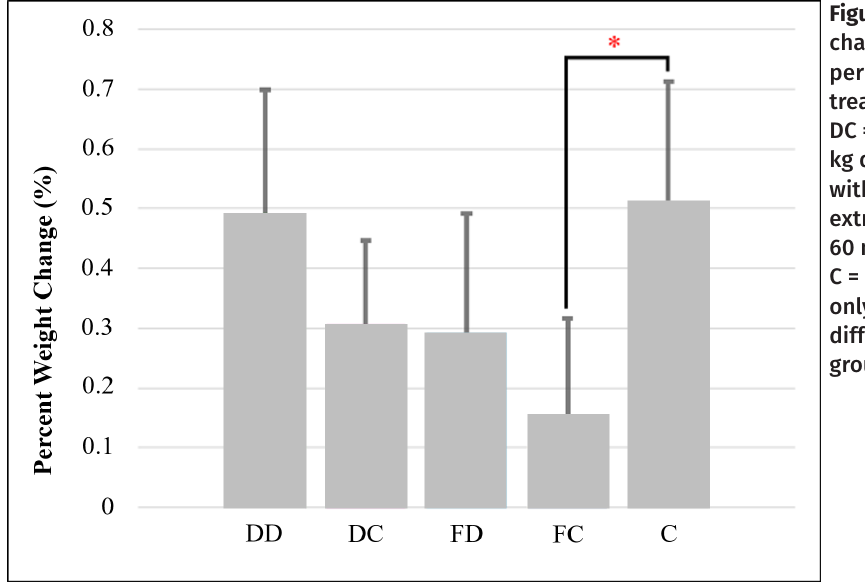
Figure 1. Average daily weight change for the whole treatment period (9 weeks). DD = group treated with 30 mg/kg decoction; DC = group treated with 60 mg/ with 30 mg/kg freeze-dried extract; FC = group treated